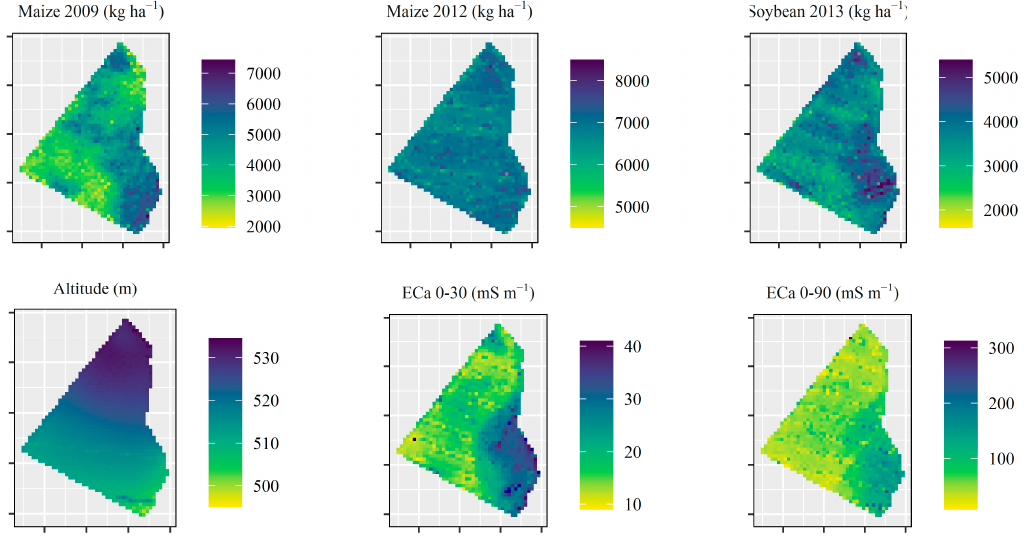
Figure 2. Data layers are used for delimiting the management zones. The data distribution of yield, ECa, and altitude are presented in Figure 3. Maize 2012 and Soybean 2013 show data distribution close to the normal distribution, unlike the other attributes. The ECa coefficient of variation (CV) ranged from 40.1%, for the 0 to 0.30 m depth, to 52.8%, for the 0 to 0.90 m depth, indicating substantial variability. A flatter distribution indicates higher dispersion of the collected data, while a bell-shaped curve indicates data concentrating around the mean of the data set. These results show that the variation in yield data was greater for the maize harvest in 2009 than in 2012. Low variance and high average in the 2012 maize yield map compared to 2009 probably prevent the expression of low-performance management zones, which would make it difficult to correlate the layers to management